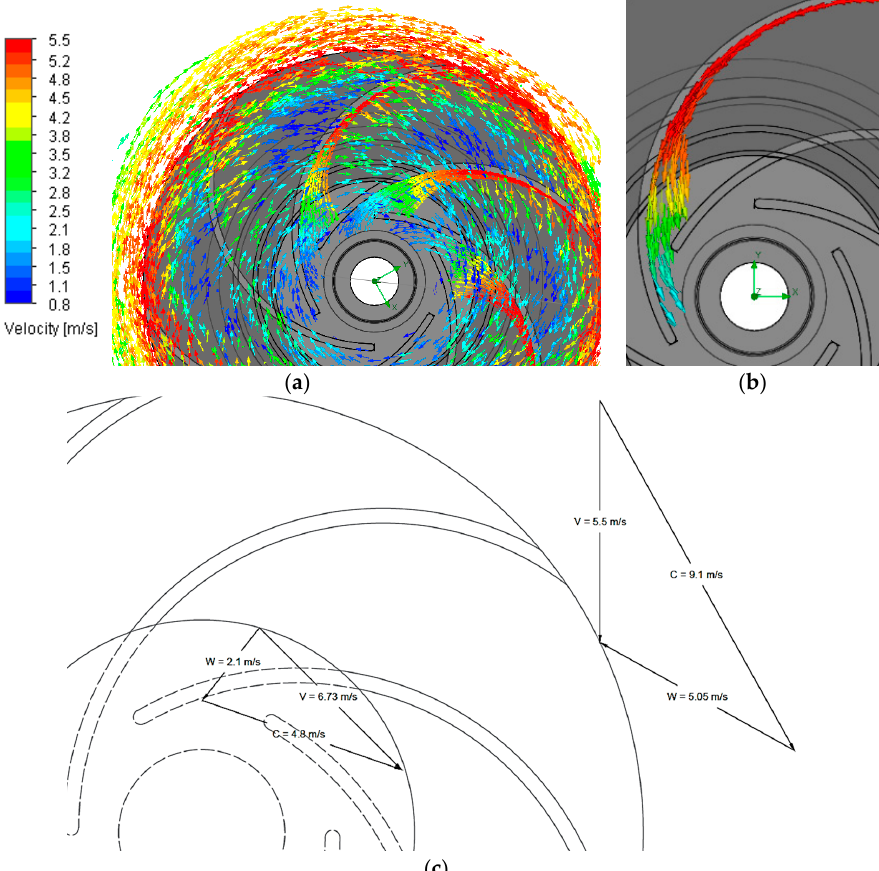
Figure 10. Velocity triangles obtained by CFD simulation for the best efficiency point (BEP): ( a ) Absolute fluid path; ( b ) relative fluid path; ( c ) triangle of velocities at inlet and outlet of the impeller.